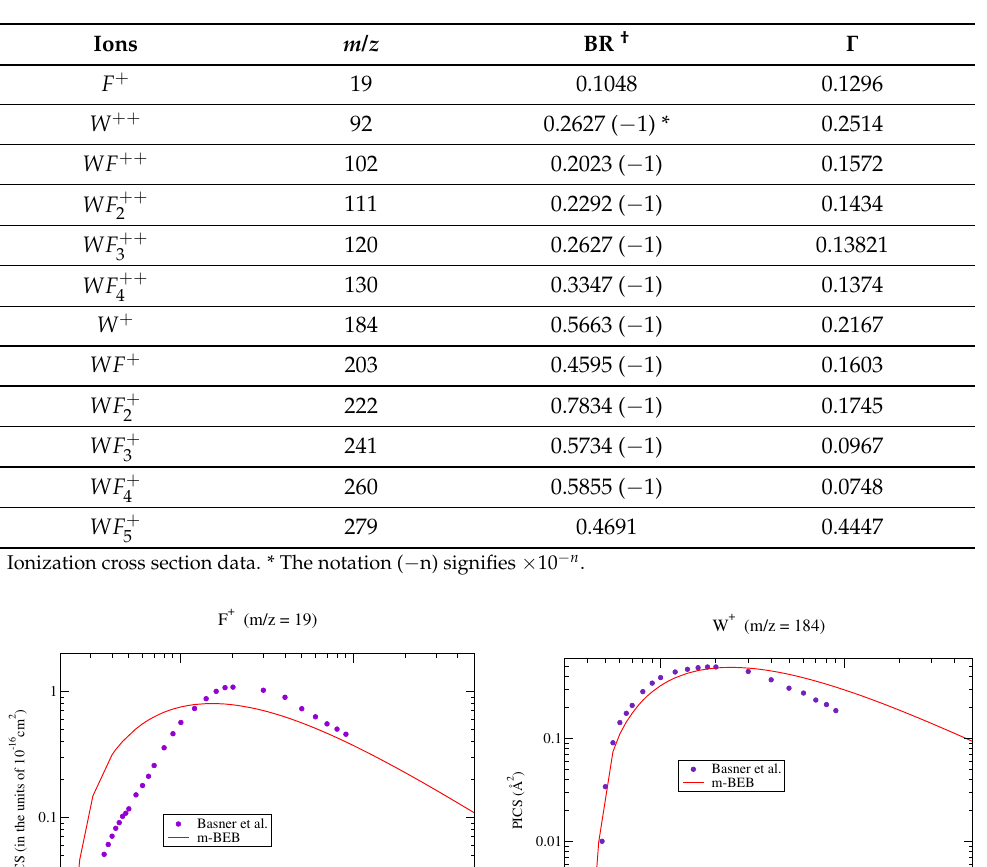
Table 2. Branching ratios and Normalization constant ( Γ ) of various cations of WF 6 produced by elec- tron impact dissociation at 140 eV. These are obtained using the cross section data of Basner et al. [21].